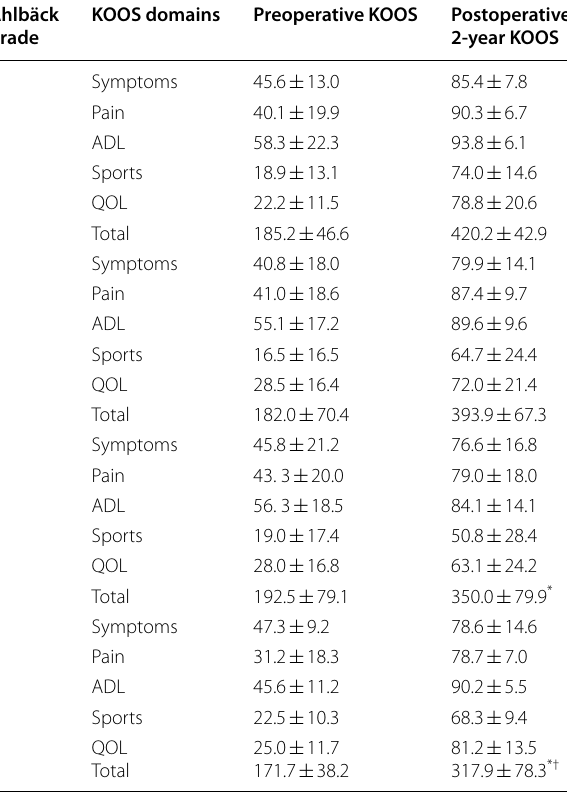
Table 6 Relationship between KOOS sub-score and Ahlbäck